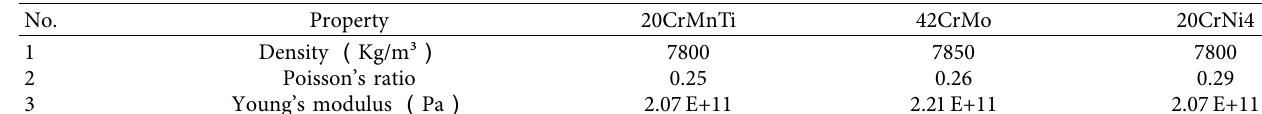
Figure 8: .3D model of gears. (a) 3D model of planetary gear. (b) 3D model of helical gear. Table 3: Material properties of gears.